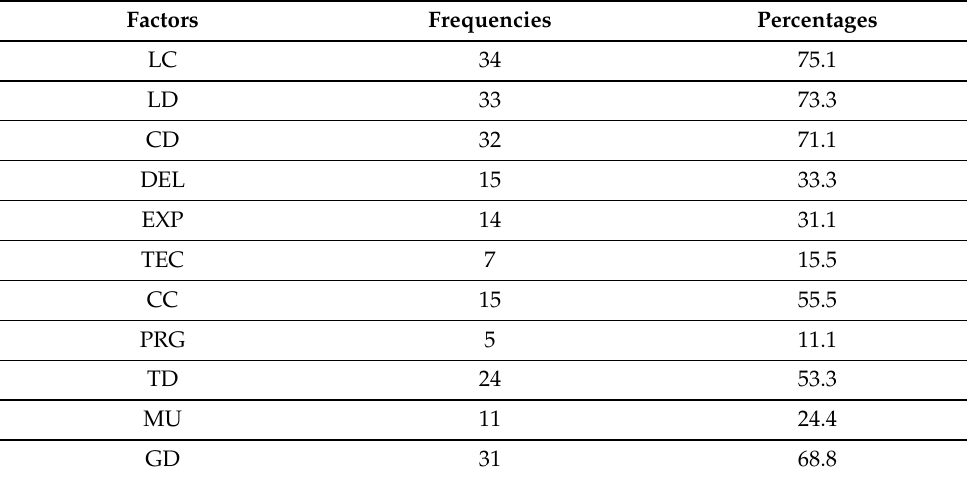
Table 3. Summary of factors affecting